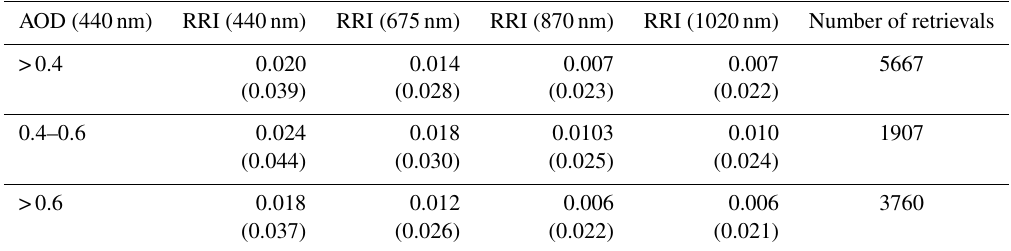
Table 11. Statistics, average values and standard deviations (in parentheses) of the difference in the RRI retrievals of V2 and V3 for the Kanpur site. The difference is defined as V3 − V2.